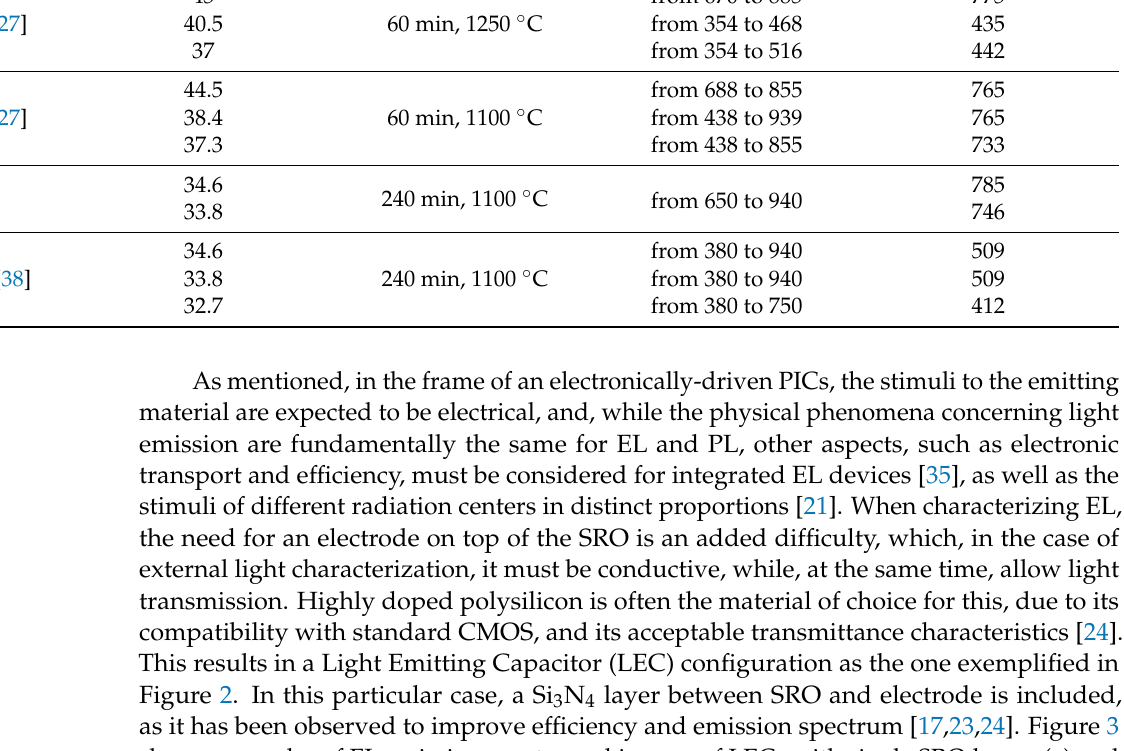
N bi-layers (not on scale) [24]. Figure 2. Light Emitting Capacitor stack structure based on SRO/Si 3 4